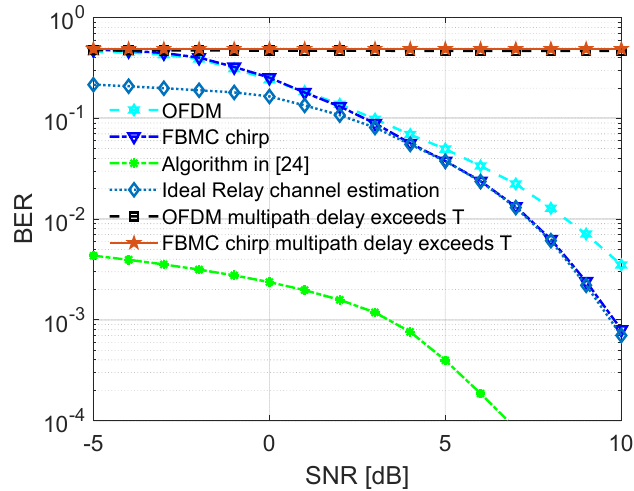
Figure 11. Simulation results of the joint system communication.